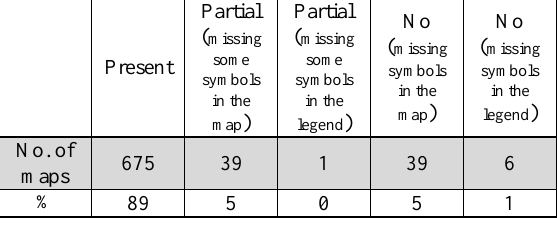
Table 2 Presence of consistency between map and legend symbols